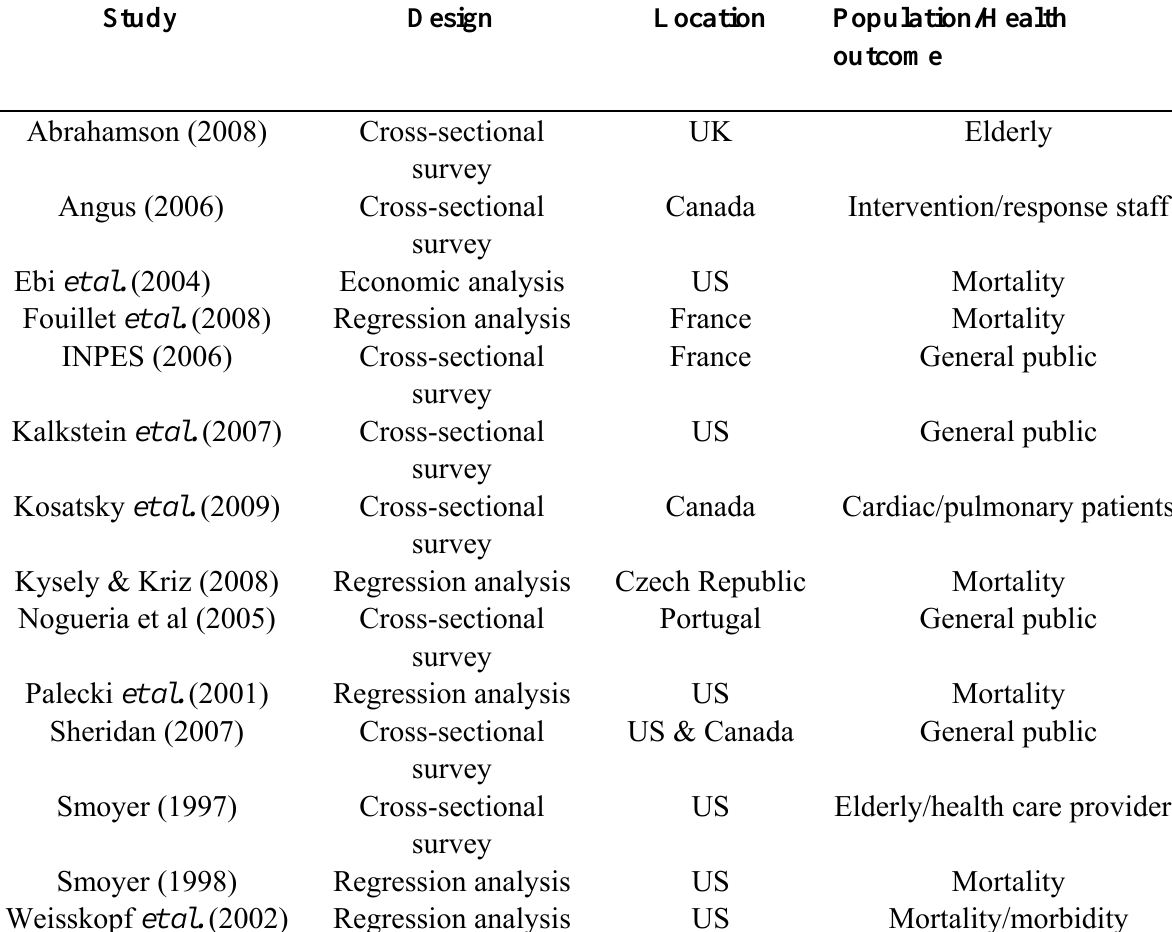
Table 1. Overview of Studies Included in this